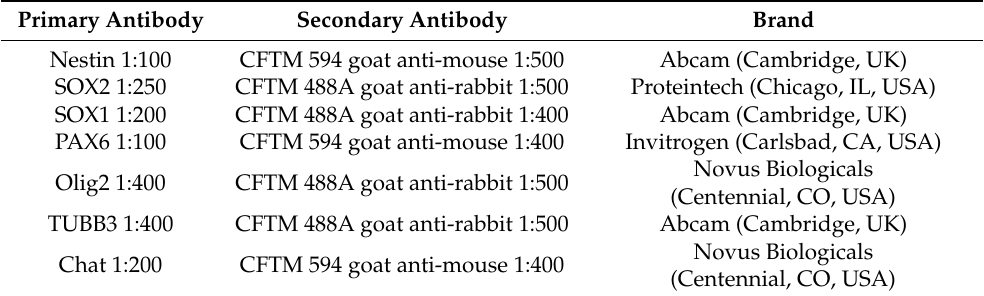
Table 1. Primary and secondary antibodies used for the immunofluorescence